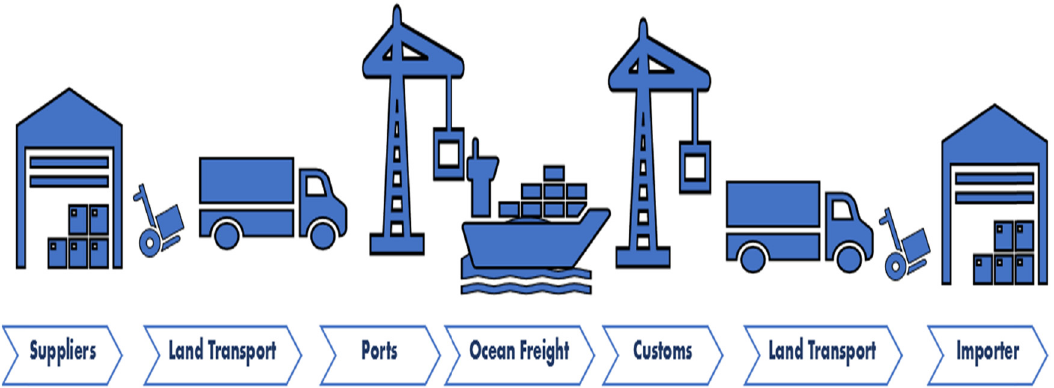
Figure 1: The work fl ow of the traditional SC